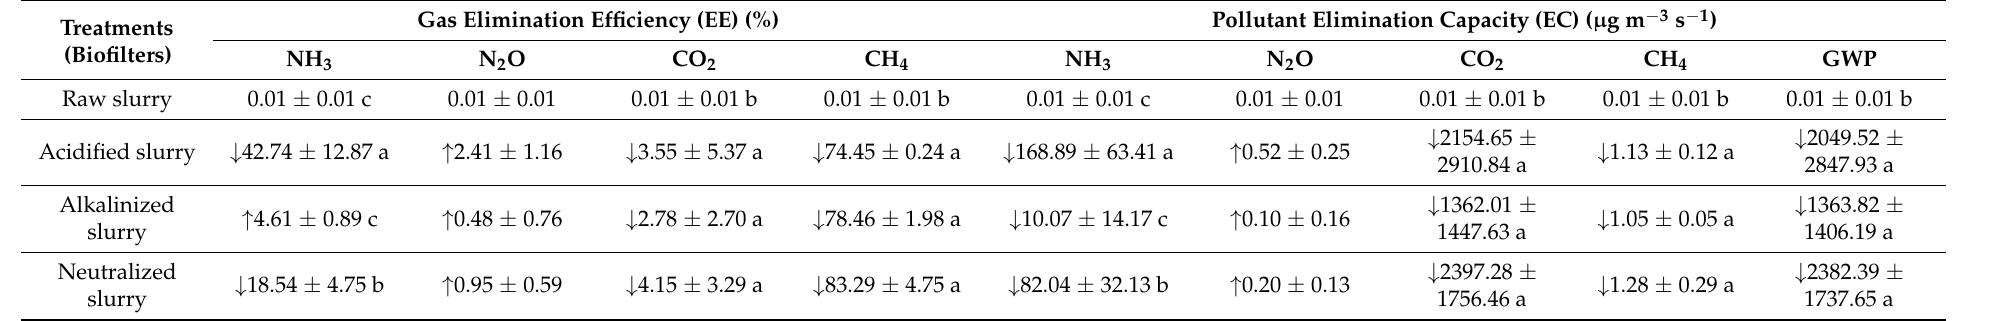
Table 5. Gas elimination efficiency and pollutant elimination capacity in the biofilter outlet air of each treatment (mean ± standard deviation) ( n =